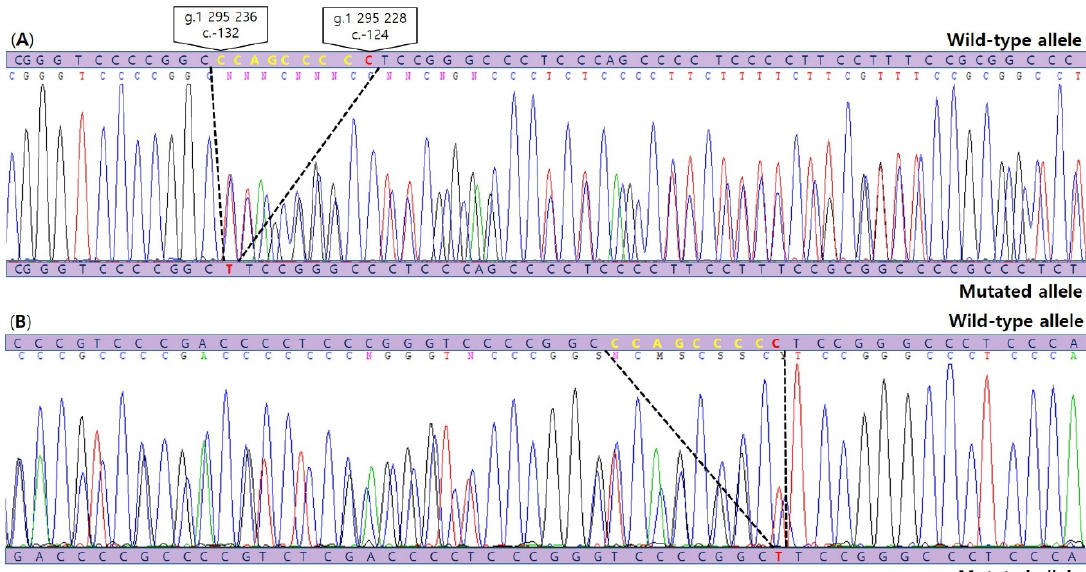
Figure 3. Sanger sequencing chromatograms ( A : forward sequence, B : reverse complement sequence) illustrating detection of the c.1-132_1-124delinsT, composed of a novel 8 bp deletion mutation (c.-132_c.-125del) (yellow) as well as the common C228T(c.1-124C>T) TERT promoter mutation (red) in SVPTC.